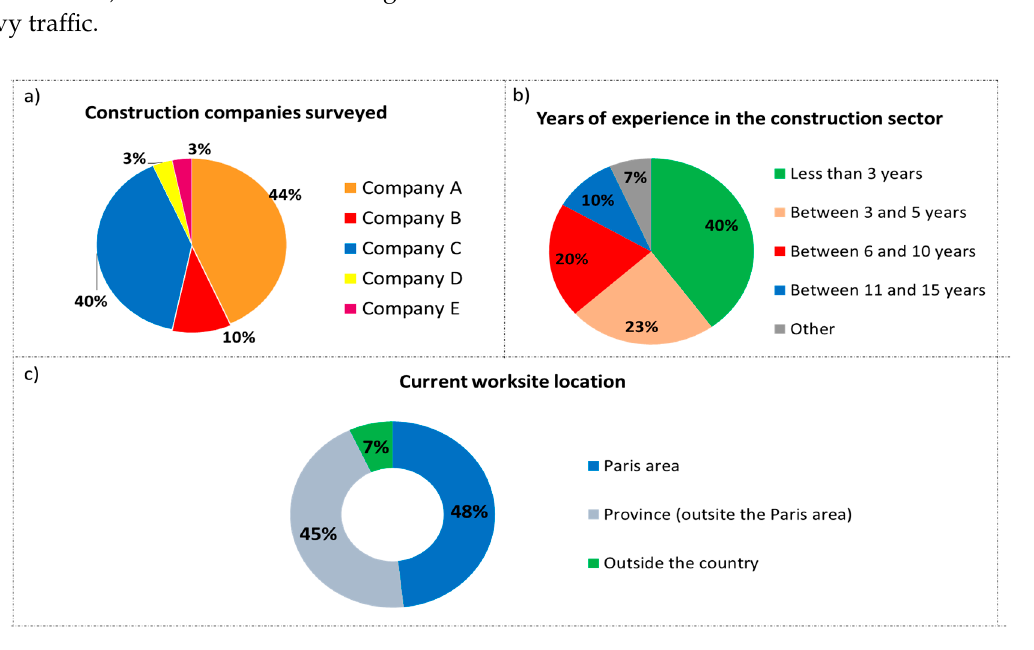
Figure 2. Populations’ characteristics: sample profile.